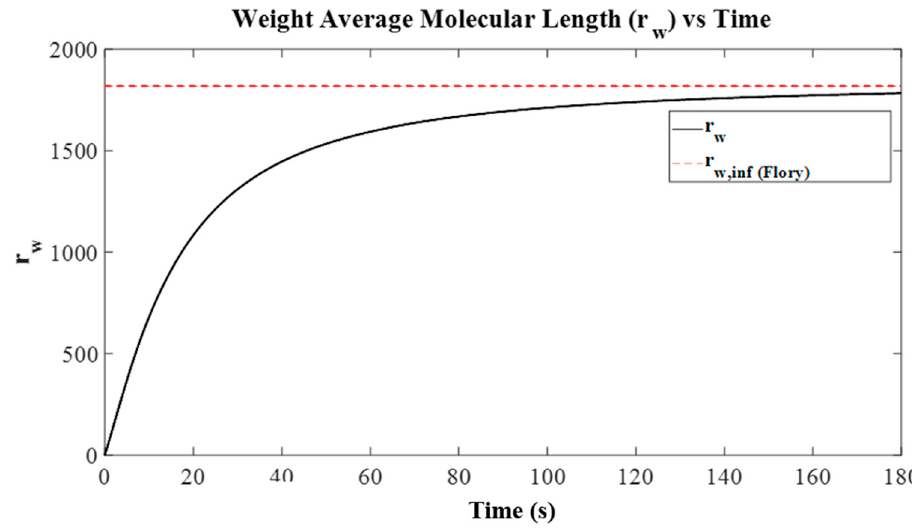
Figure 4. Weight average molecular length according to Equations (36) and (37) ( K P = 100/s, K I = 1/s, K T = 0.1/s, K D = 0.01/s).